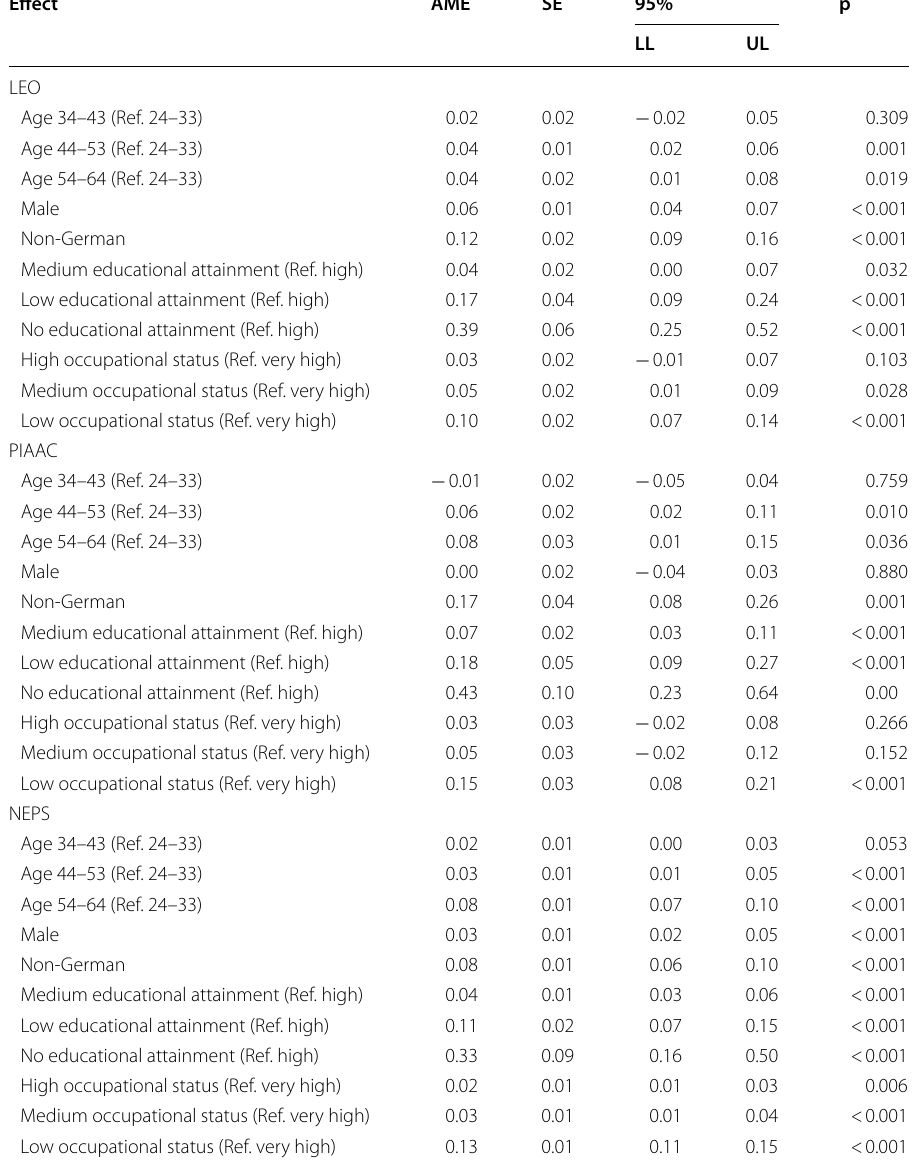
AME Average Marginal Effect; LL and UL indicate the lower and upper limits of a confidence interval,